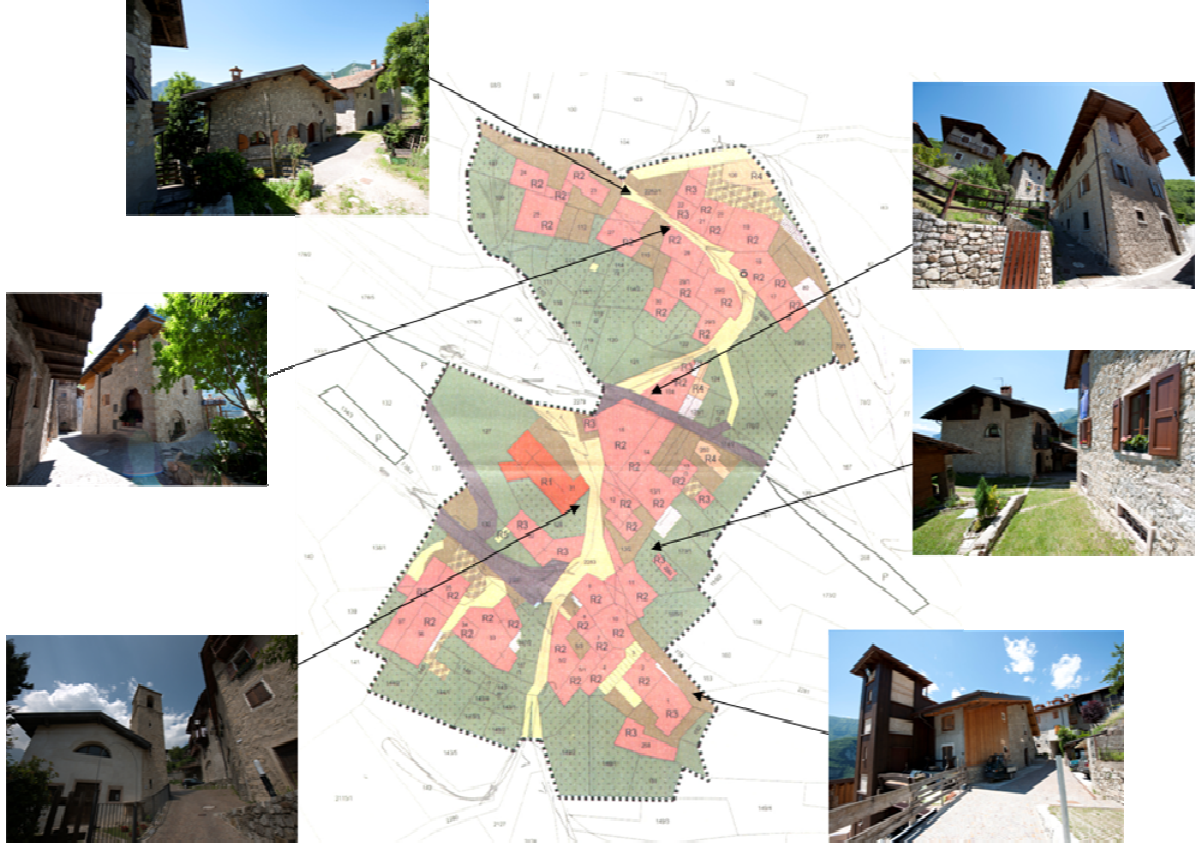
Figure 9: The village of Calvola, in an old cadastral map of the early XIX century (Asburgic period), with some picture showing its narrow streets, court yards, stone houses, overhanging roofs, occlusions, etc.